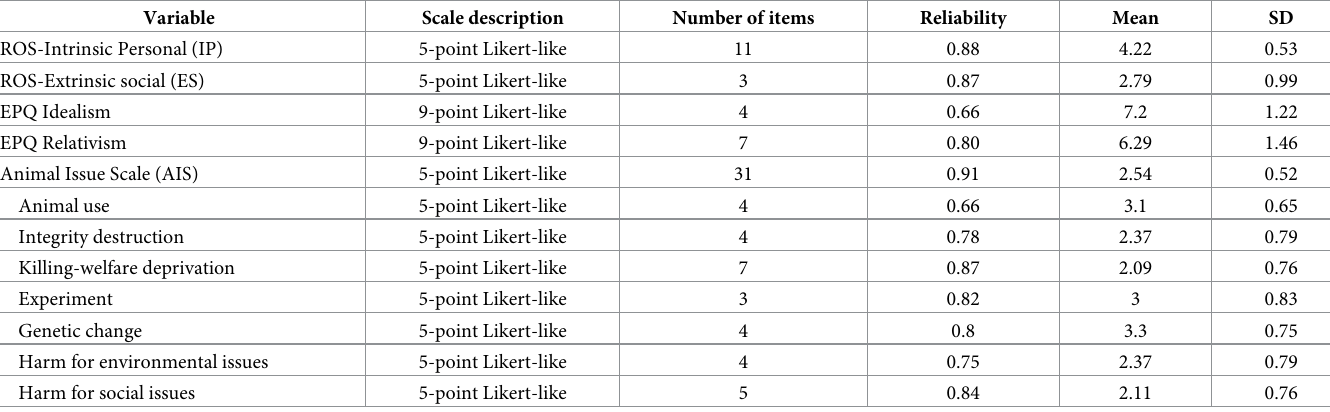
Table 5. Descriptive statistics and measurement characteristics for